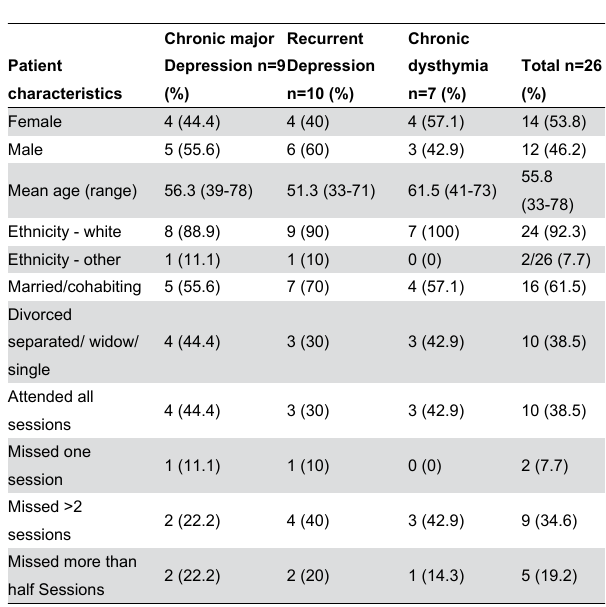
Table 2. Patient characteristics by